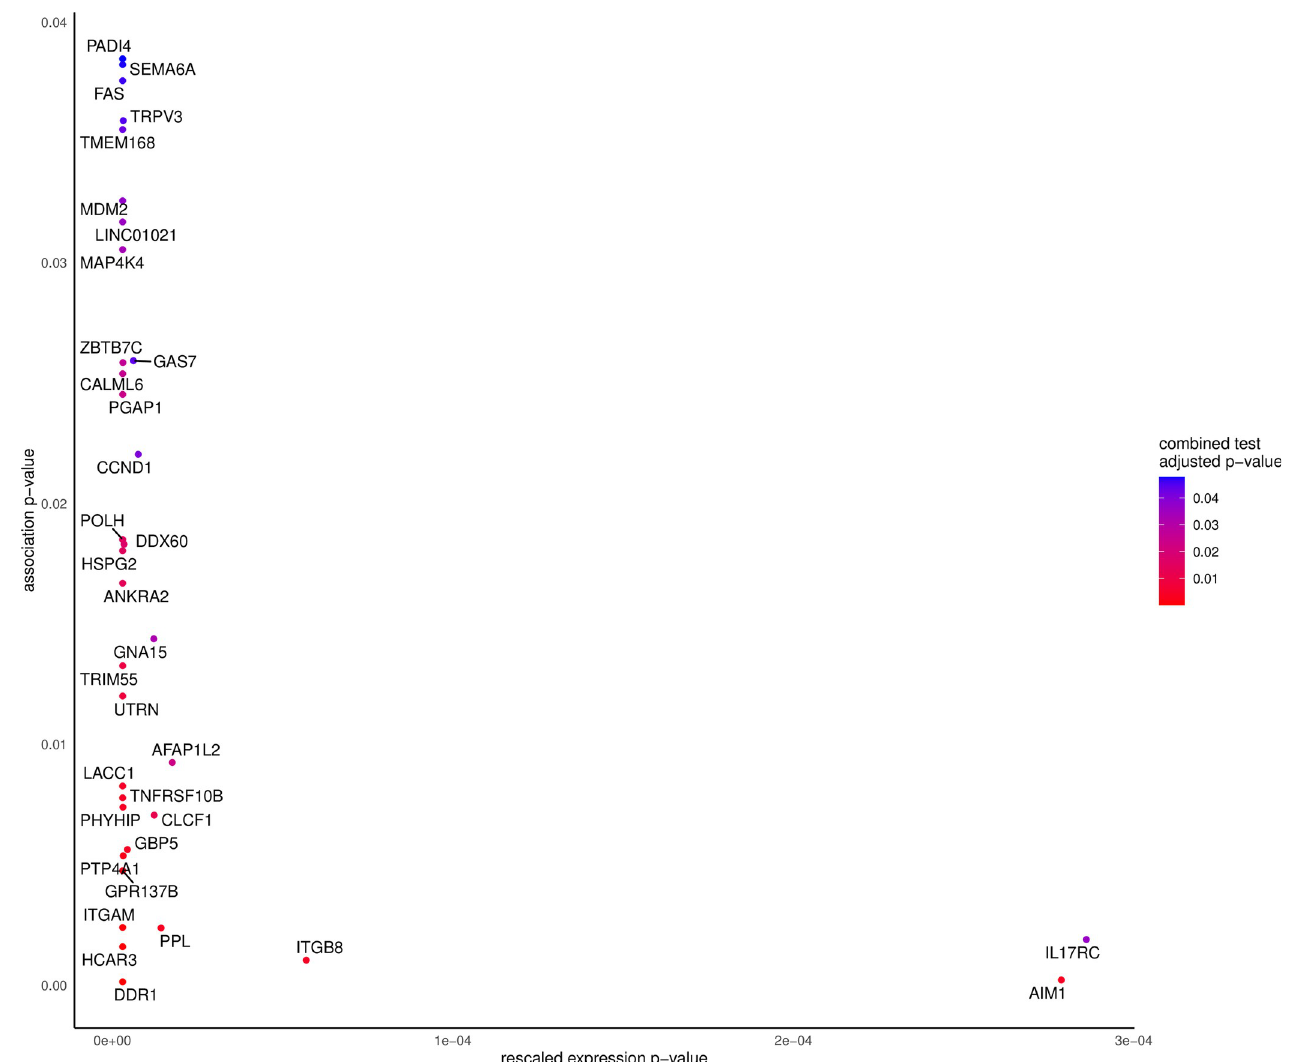
Fig 3. Graphical representation of the relationship between the p-values of the combined test (color coded), the lymphoblastoid cell line expression test (x-axis), and the whole-exome sequencing association test (y axis): We see that the majority of the genes that are associated with a significant combined test statistic show very low p values for the expression test and that the p-value of the combined test increases with the p-value of the association